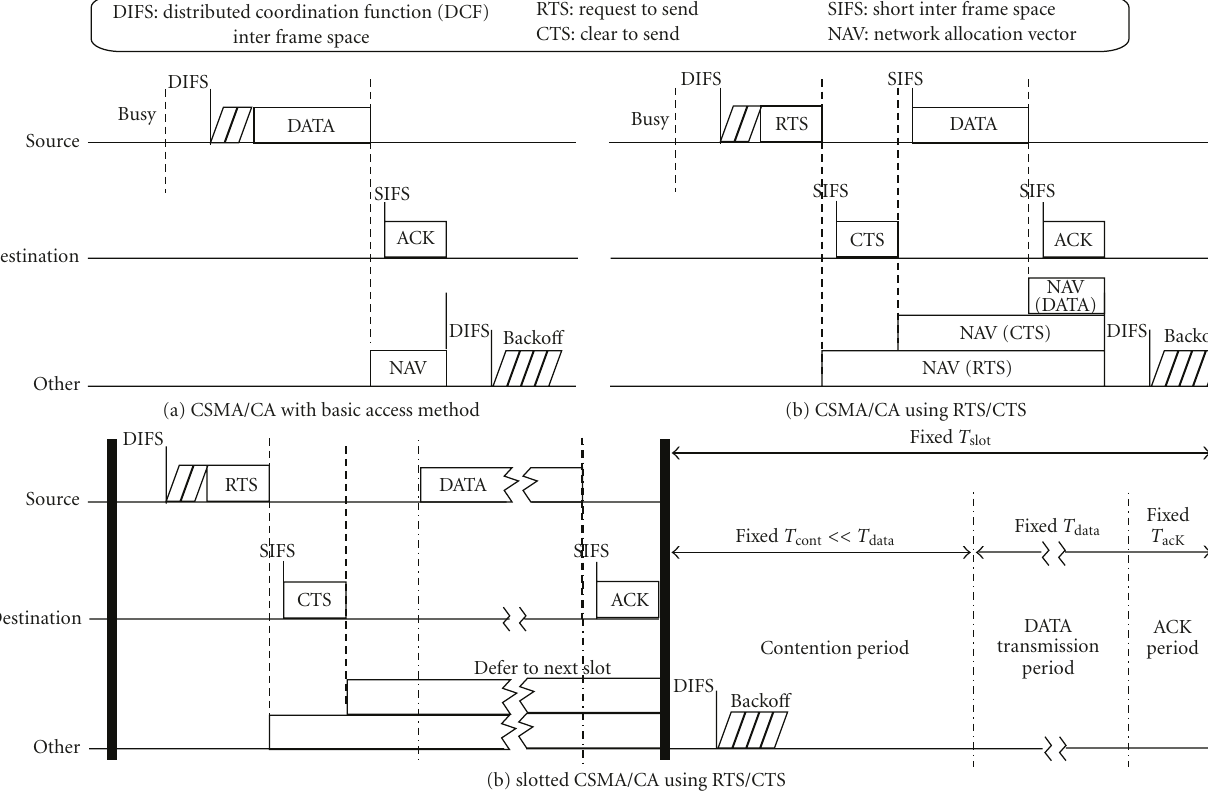
Figure 2: Two CSMA/CA